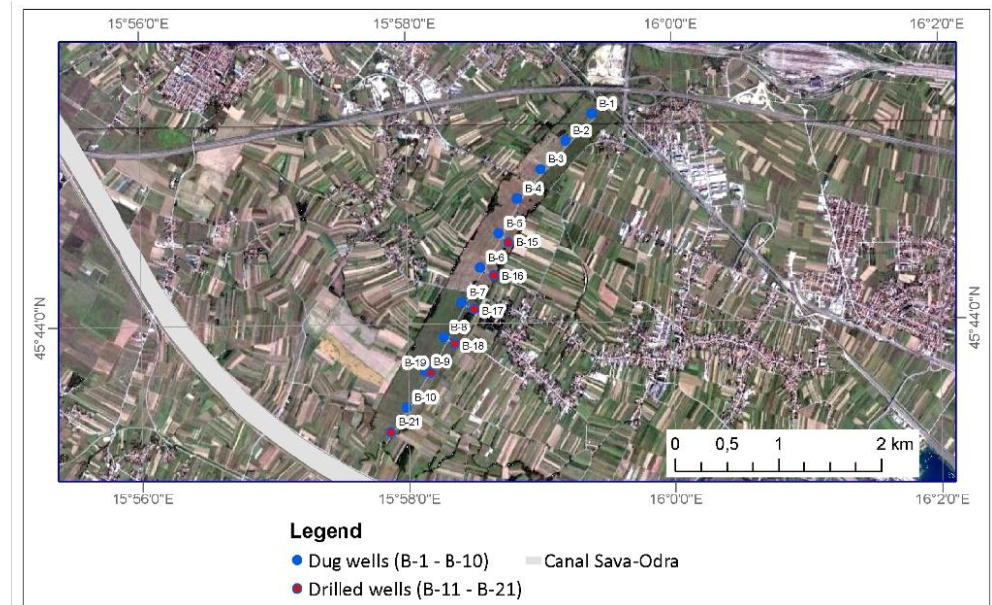
Figure 9. Wells of the Mala Mlaka water pumping